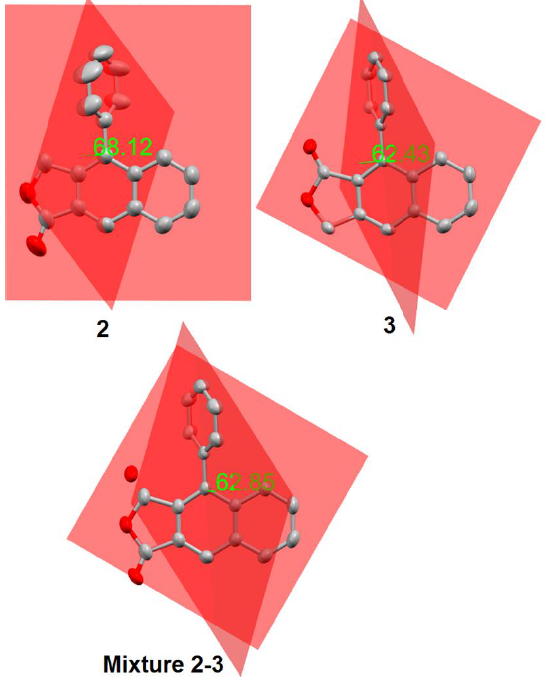
Figure 2. The torsion angles ( ° ) between the phenyl group and the naphthofuranone moiety: 2 : 68.12 ° , 3 : 62.43 ° and mixture 2-3 : 62.85 ° . In structures 2 and 3 and mixture 2-3 and 5 , intermolecular close-contacts were ob- served, forming a chain packing along the b-axis. Structures 2 , 3 and mixture 2-3 all have a C2 rotation symmetry with intermolecular close-contact distances of 2.607 Å ( 3 ), 2.52 Å ( 2 ), 2.639 Å ( mixture 2-3 ) and angles of 160.15 ° ( 3 ) 133.63 ° ( 2 ), 160.44 ° ( mixture 2-3 ). How- ever, structure 5 has mirror symmetry with an intermolecular close-contact distance of 2.629 Å and an angle of 146.79° (Figure 3).